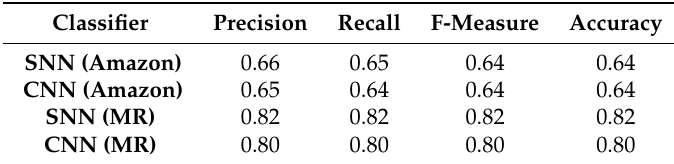
Table 8. Performance metrics for Amazon reviews and MR reviews using the pretrained neural models on the IMDb